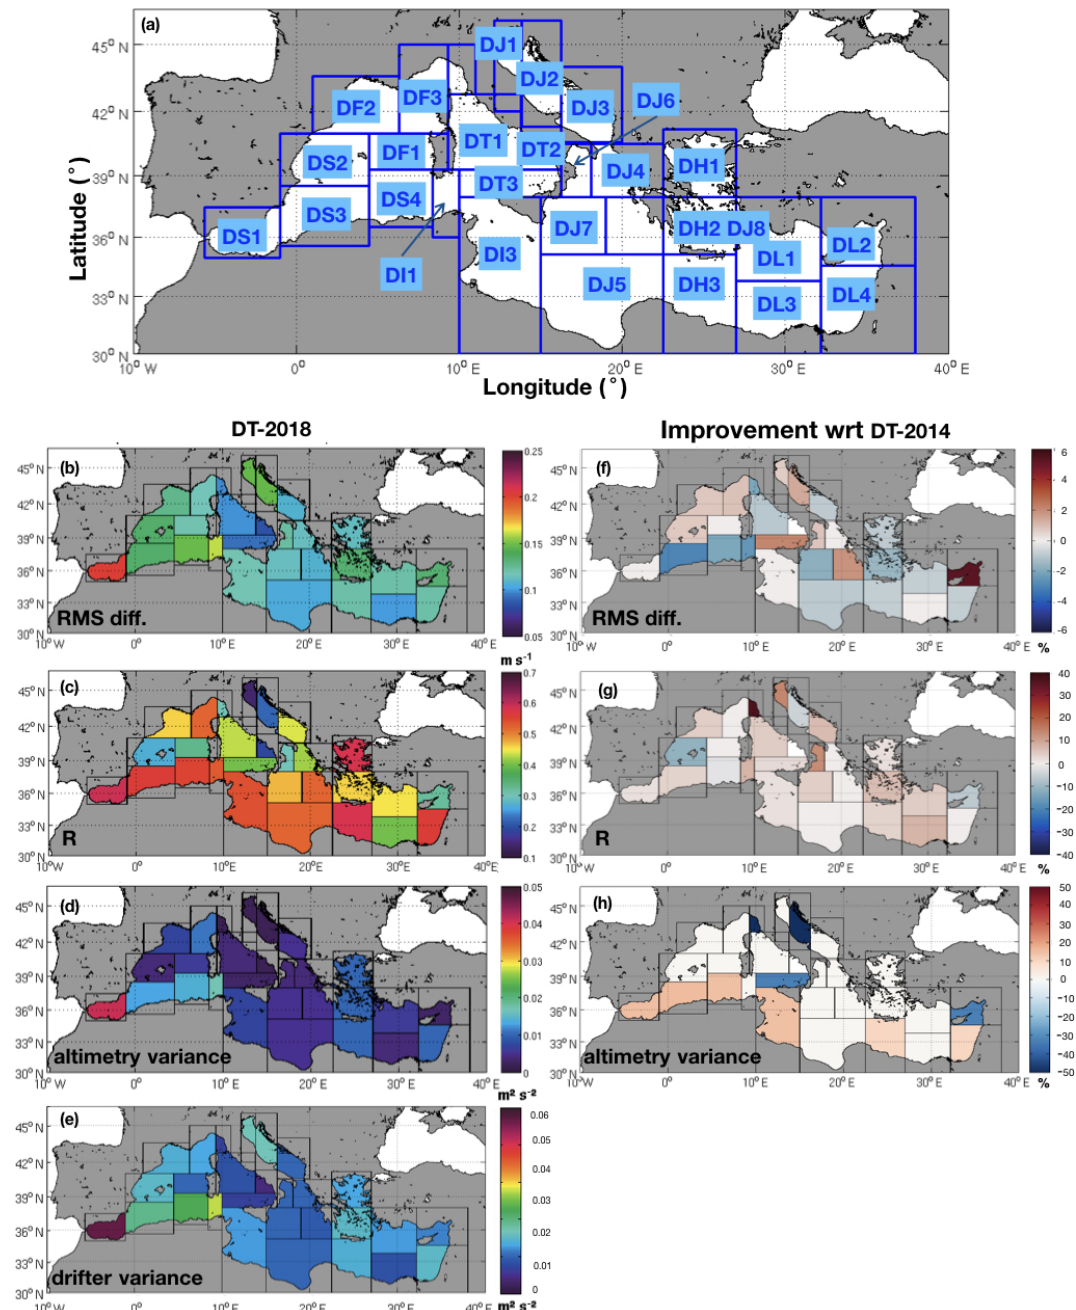
Figure 11. (a) Map of the Mediterranean Sea showing the geographical limits and the nomenclatures of the regions (blue boxes) as defined in Manca et al. (2004) wherein drifter data are available in the western sub-basin: Alboran Sea (DS1), Balearic Sea (DS2), western and eastern Algerian (DS3 and DS4), Algero–Provençal (DF1), Liguro–Provençal (DF3, DF4), Gulf of Lion (DF2), Tyrrhenian Sea (DT4), Sardinian channel (DI1), Tyrrhenian Sea (DT2, DT3), and the Strait of Sicily (DI3). In the eastern sub-basin: Adriatic Sea (DJ1–DJ3), Ionian Sea (DJ4–DJ8), Aegean Sea (DH1, DH2), Cretan Passage (DH3) and Levantine basin (DL1–DL4). (b–e) Maps of the Mediterranean Sea showing the comparison between the DT2018 regional altimetry product and the drifter in situ observations within the geographical limits and the nomenclatures of the regions defined in (a) . The statistical parameters shown are (b) RMS difference, (c) correlation coefficient, (d) altimetry variance and (e) drifter variance. (f–h) Improvements (%) of the comparisons between the DT2018 regional product and drifter in situ observations with respect to the comparisons by using the DT2014 product within the geographical limits and the nomenclatures of the regions defined in (a) . The statistical parameters shown are (f) RMS difference, (g) correlation coefficient and (h) altimetry variance. Positive values denote an improvement of the DT2018 regional product over